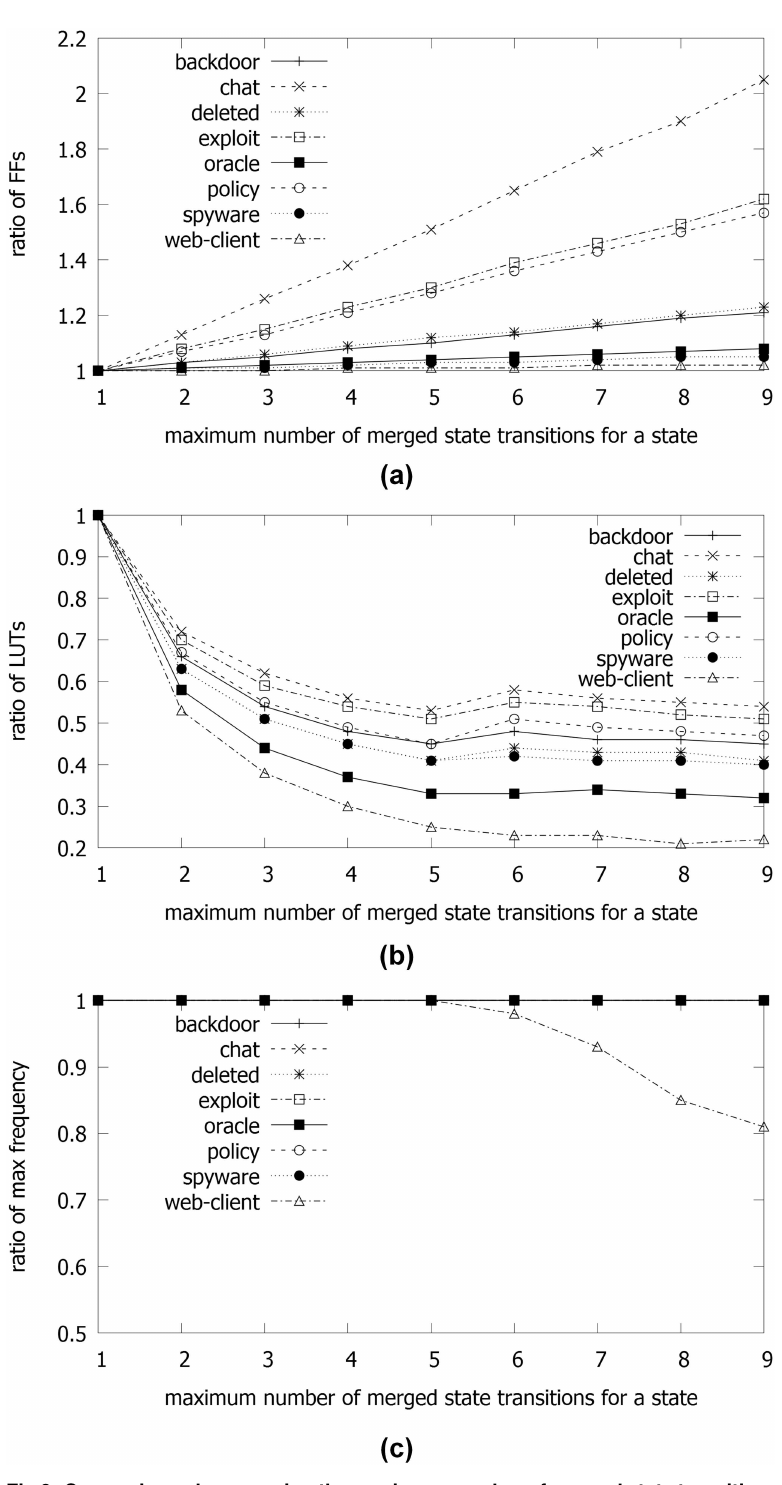
Fig 9. Comparisons by sweeping the maximum number of merged state transitions for a state M : (a) ratios of used FFs to that when M = 1; (b) ratios of used LUTs to that when M = 1; (c) ratio of the maximum operating frequency F to that when M =